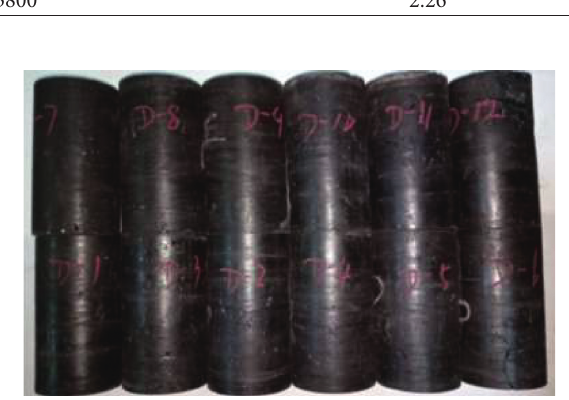
Figure 1: Typical coal samples before water immersion.